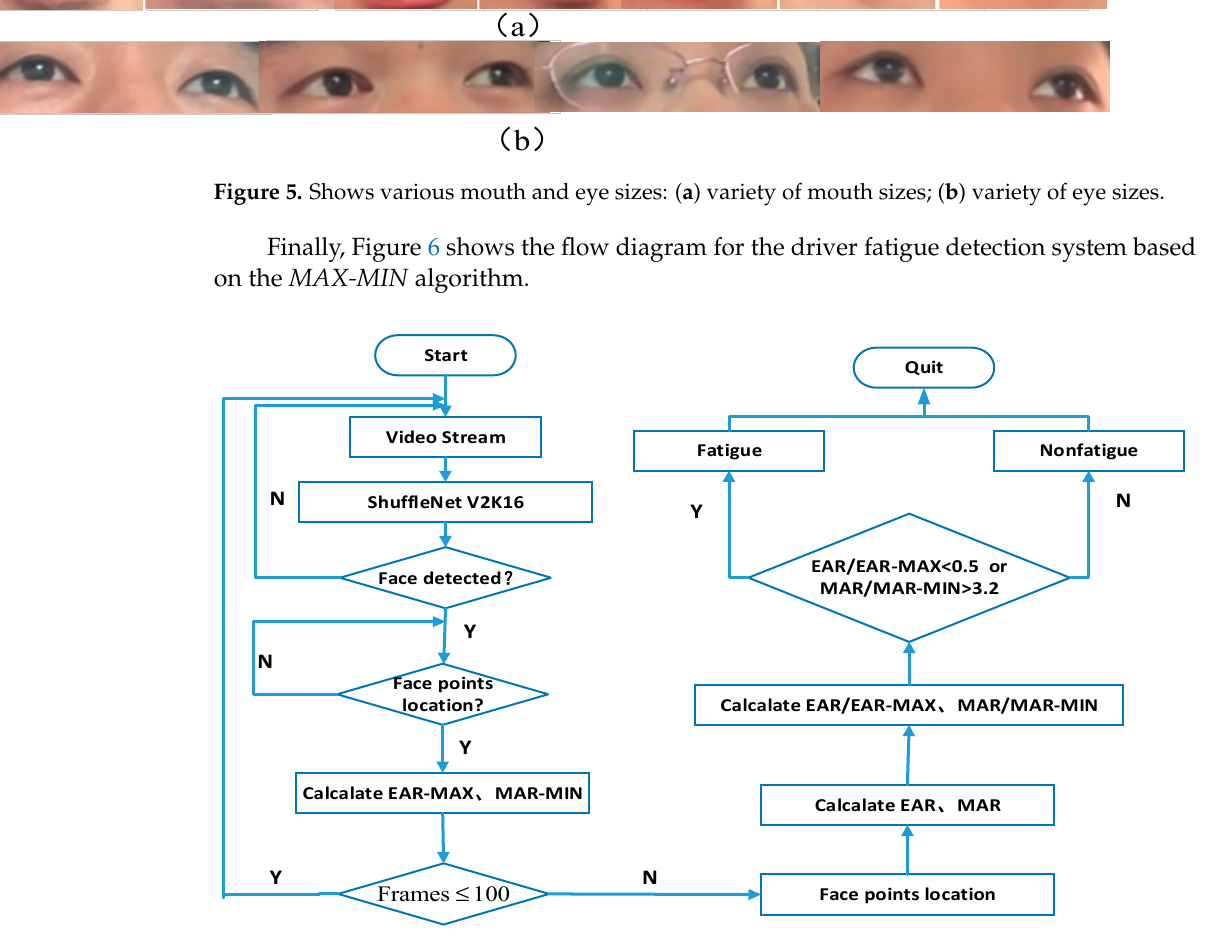
Figure 6. Flow chart of the fatigue detection algorithm.